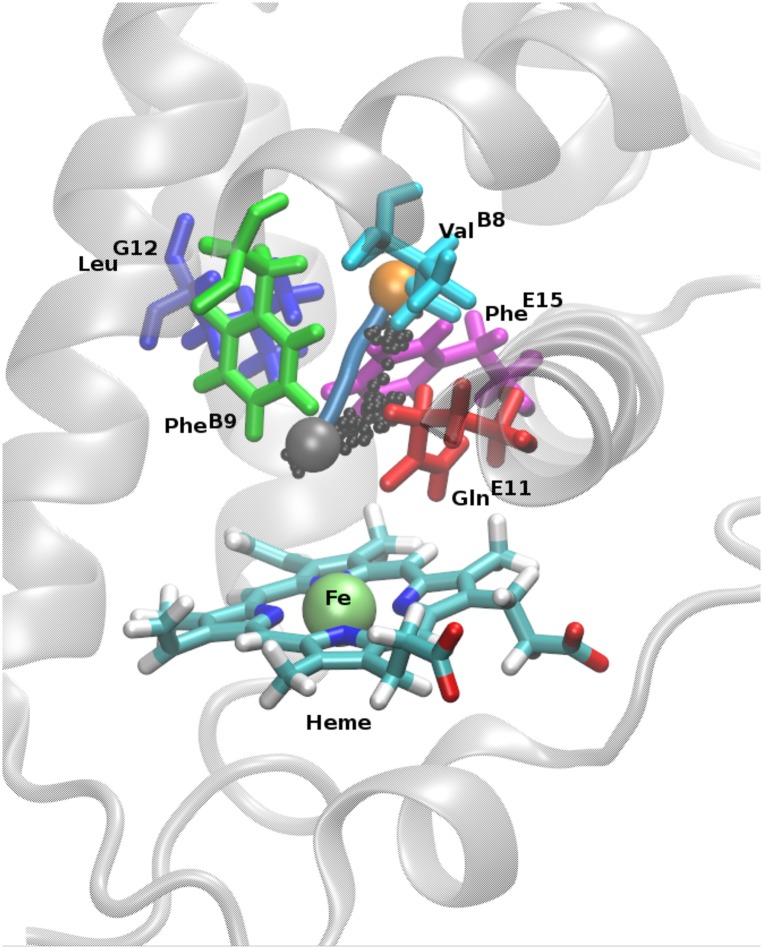
Xe1a↔Xe2 transition region.Xe1a and Xe2 pockets (orange and gray sphere, respectively), together with surrounding residues ValB6 (cyan), PheB9 (green), PheE15 (magenta), GlnE11 (red), and LeuG12(blue). The minimum energy transition path (in blue cylinder) and one particular transition path (small black spheres) are shown between the two pockets. In grey (background) the ribbon structure of the protein and in licorice the heme-unit.